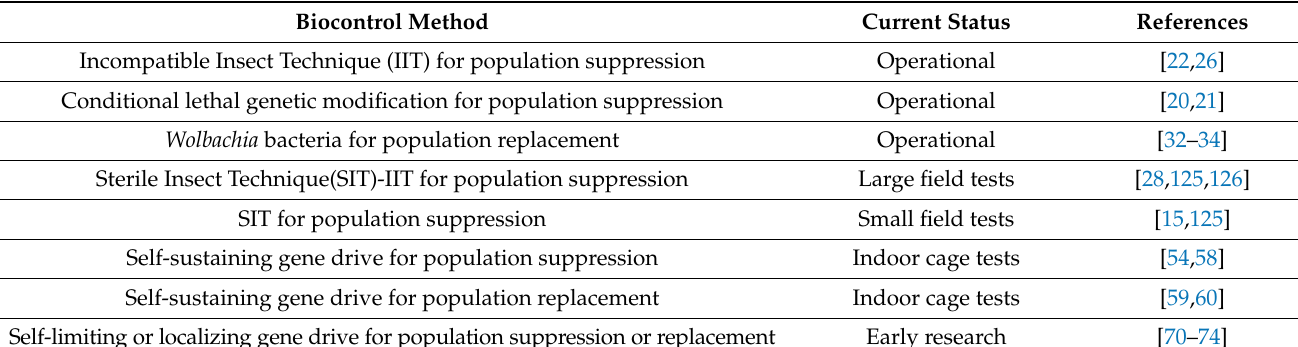
Table 1. Biocontrol approaches with application to Aedes or Anopheles mosquito